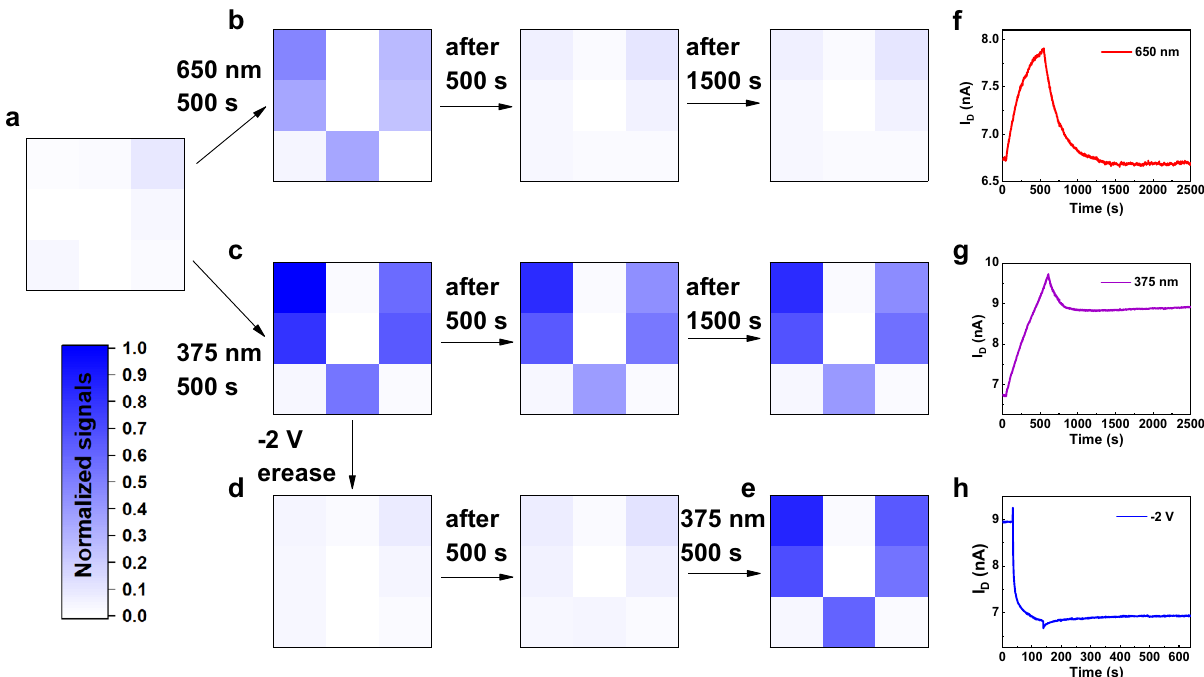
Fig. 2 Selective recognition of UV light and image memorization. a Schematic structure of a 3 × 3 neuromorphic transistor array. b , c illustrate the image memory of the letter V under 650 nm and 375 nm, respectively, at 64 mW/cm 2 for 500 s. Retention characteristics were also investigated at 1000 s and 2500 s. d Electrical erasing process ( − 2 V for 100 s). e UV light rewriting (64 mW/cm 2 for 500 s). f – h EPSC curves corresponds to the pixel of the fi rst row and column of the transistor array. The gray scales are the normalized current change. A constant source-drain voltage V SD = 50 mV was applied to monitor the channel